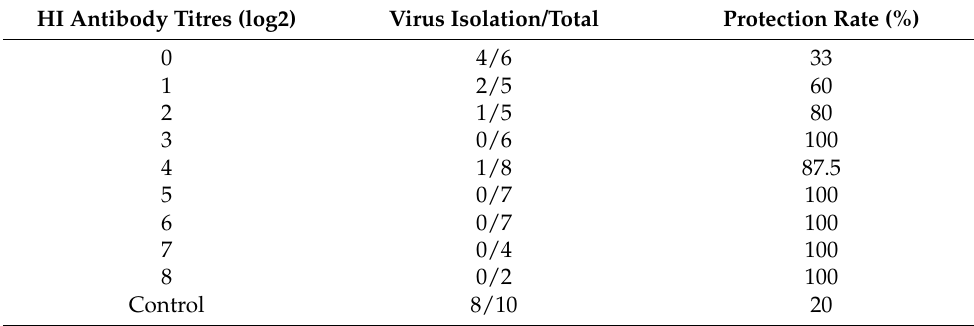
Table 2. Protective efficacy against H9N2 challenge in ducks.